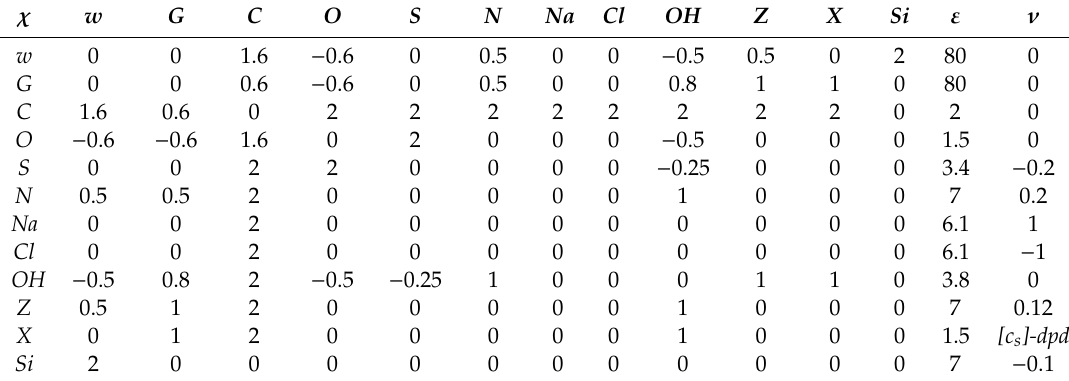
Table 1. Flory–Huggins interaction parameters, χ , between various pairs of segments, relative dielectric constant, ε , and valence, ν , of the segment types as used in SCF calculations. Segment types X , Z and G denote the deprotonated segment of carboxylic group, and the amine group of chitosan and saccharide pseudo-rings, respectively, and Si denotes the